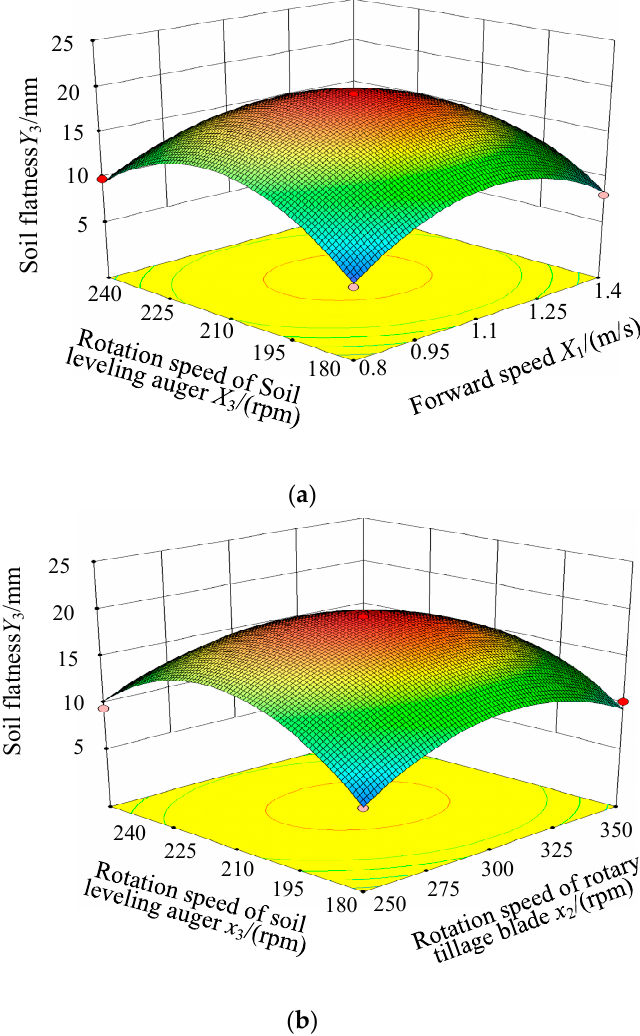
Figure 11. Response surfaces of soil flatness to interactive factors X 1 X 3 and X 2 X 3 . ( a ) Forward speed and rotation speed of leveling auger effect on soil flatness; ( b ) Rotation speed of rotary tillage blade and rotation speed of soil leveling auger effect on soil